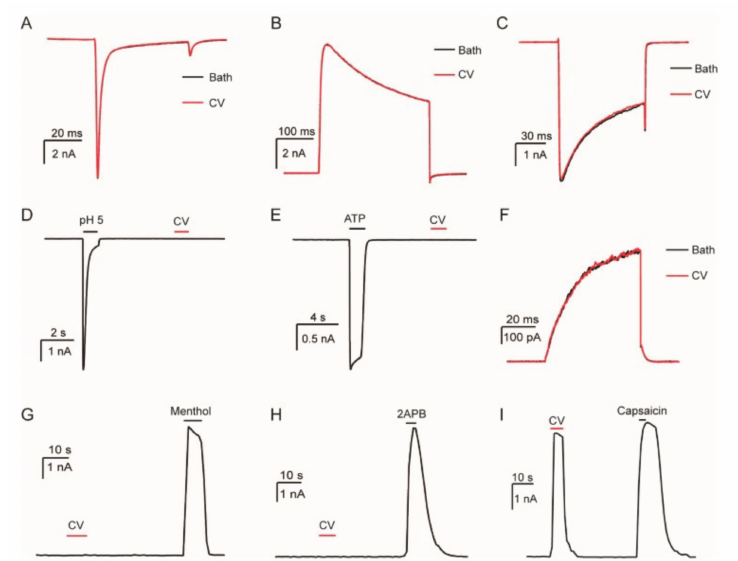
Figure 5. In these experiments, Yao et al. (2019) [43] tested the response of the crude L. consocia venom (CV) extract on pain-related ion channels: ( A ) dorsal root ganglion sodium channel (DRG-Na); ( B ) dorsal root ganglion potassium channel (DRG-K); ( C ) dorsal root ganglion calcium channel (DRG-Ca); ( D ) acid-sensing ion channel 2a (mASIC2a); ( E ) P2X ligand-gated ion channel 3 (hP2X3); ( F ) mKCNQ4; ( G ) transient receptor-potential M8 (mTRPM8); ( H ) transient receptor-potential vanilloid 2 (mTRPV2) ( I ) TRPV1. The electrophysiological profiles of L. consocia venom reveals a potent and specificity towards the TRPV1 channel with similar amplitude to the agonist, capsaicin, evoked current ( I ). No evoked currents were seen for the other channels ( A–H ). The figure was copied with permission from [43].